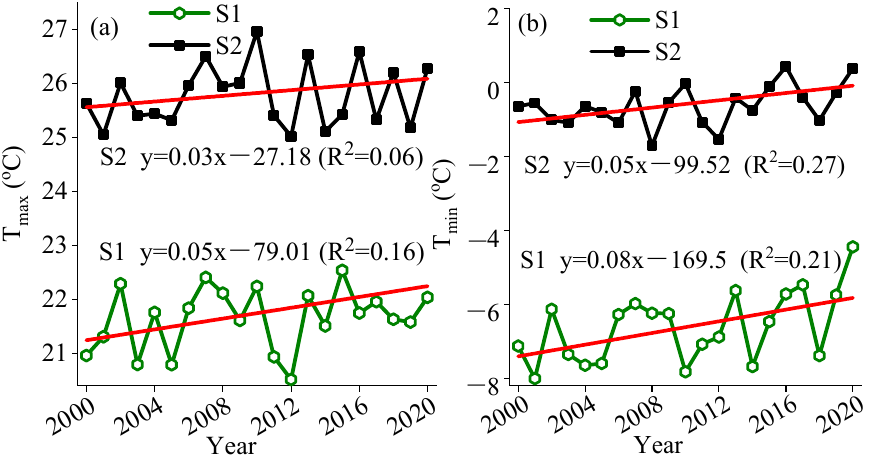
Figure 2. T max ( a ) and T min ( b ) trends in the S1 and S2 regions with arid and semiarid climate, 2000–